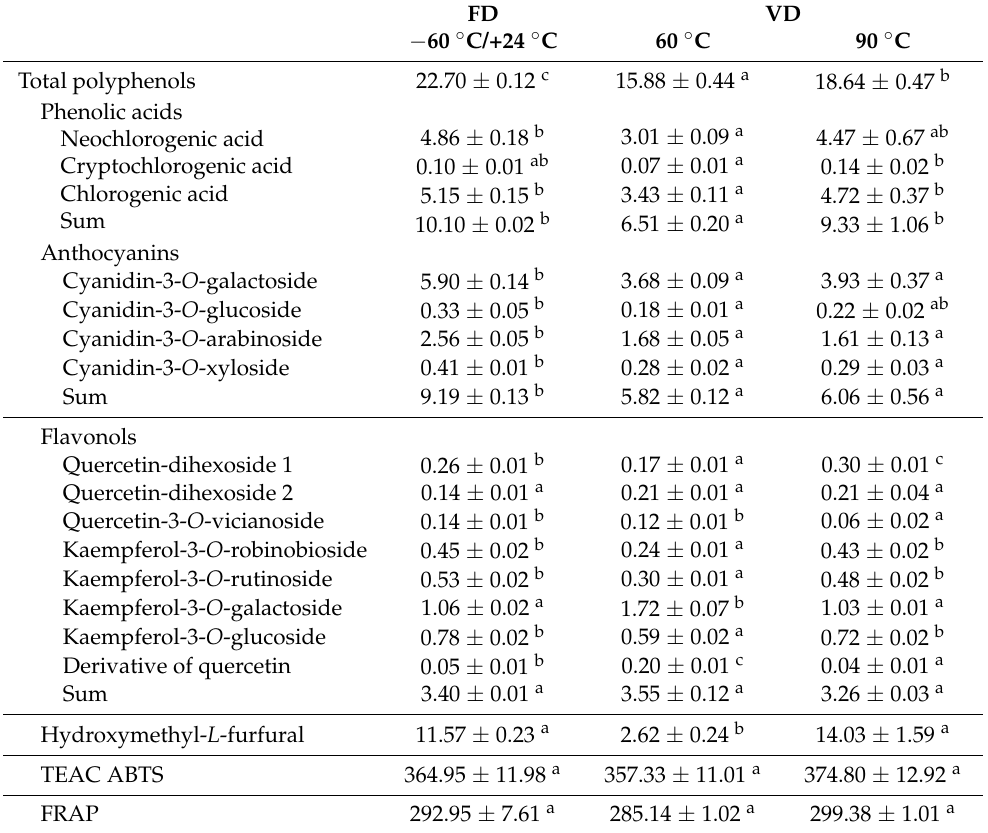
Table 2. The content of identified polyphenolics (g/100 g db), hydroxymethyl- L -furfural ( µ g/100 g db) and antioxidant capacity measured by TEAC ABTS and FRAP methods (mmol TE/100 g db) in chokeberry pomace extract powders (controls) obtained after freeze and vacuum drying (average ± standard deviation; n = 2).